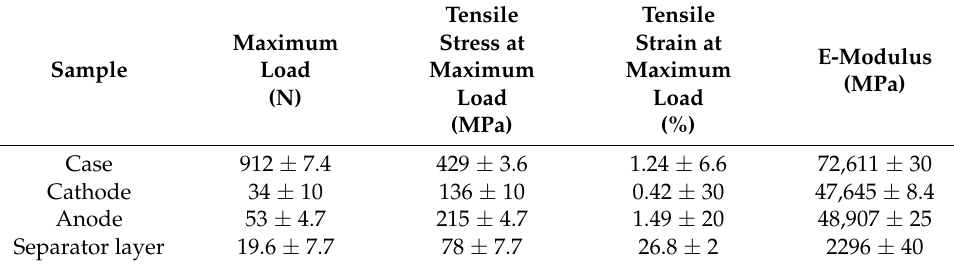
Figure 2. Stress-strain curves of individual materials of the battery. Table 2. Case samples—Tensile test